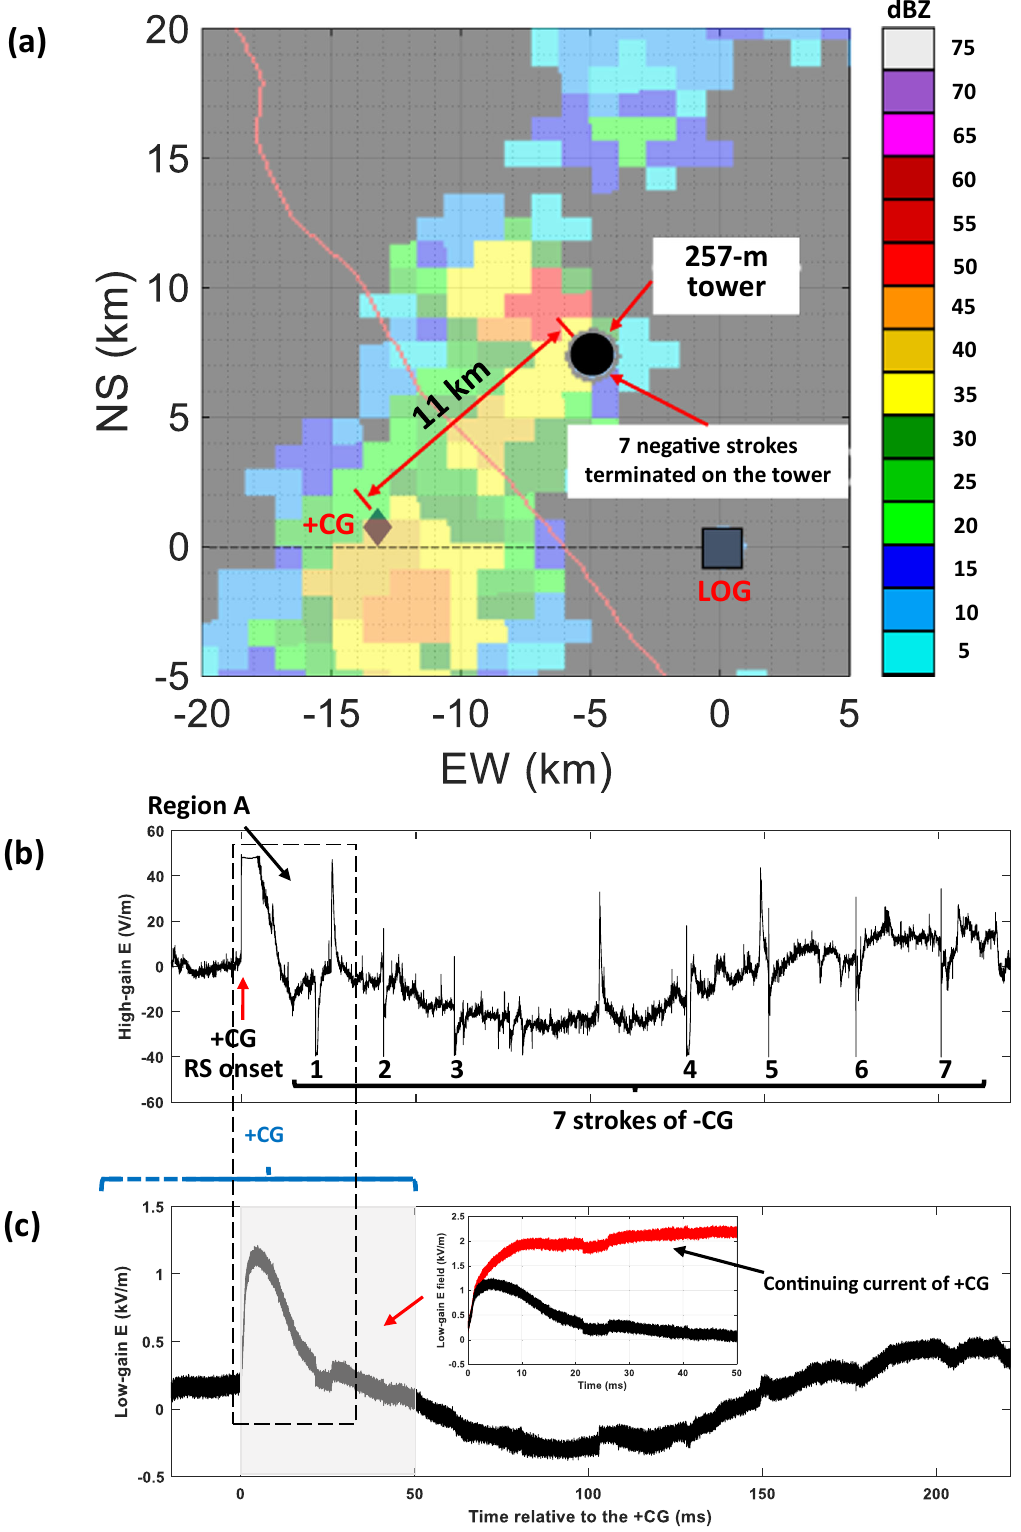
Fig. 1 Single-stroke positive Flash 1906. a NLDN data (the diamond representing + CG and seven overlapping circles representing seven return strokes (RS) of the tower-terminated -CG) superimposed on a radar re fl ectivity map. The thin broken line represents the line of sight of high-speed cameras installed at the Lightning Observatory in Gainesville (LOG) (the square in the lower-right corner of the map). b , c High-gain ( τ = 440 µ s) and low-gain ( τ = 10 ms) electric fi eld waveforms, respectively, displayed on a 240-ms time scale. The inset in c shows the low-gain E- fi eld waveforms (from 0 to 50 ms) before (black) and after (red) compensation for instrumental